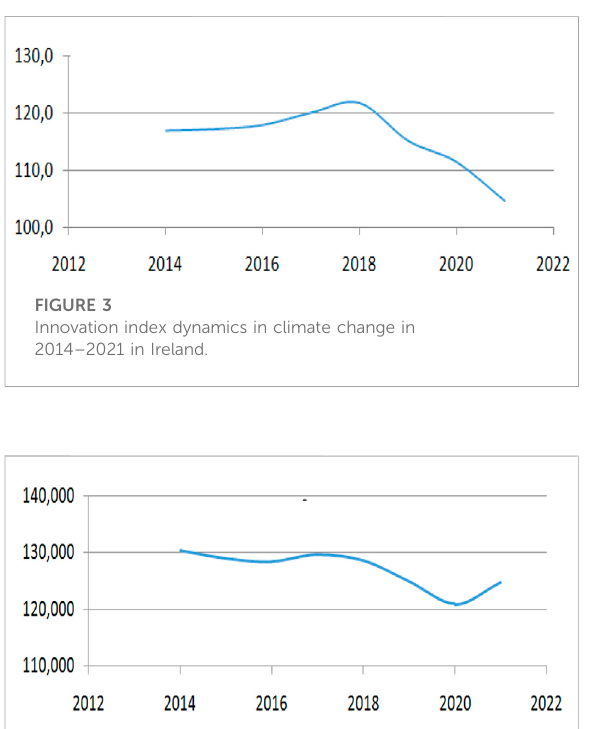
FIGURE 4 Innovation index dynamics in climate change in 2014 – 2021 in Sweden.